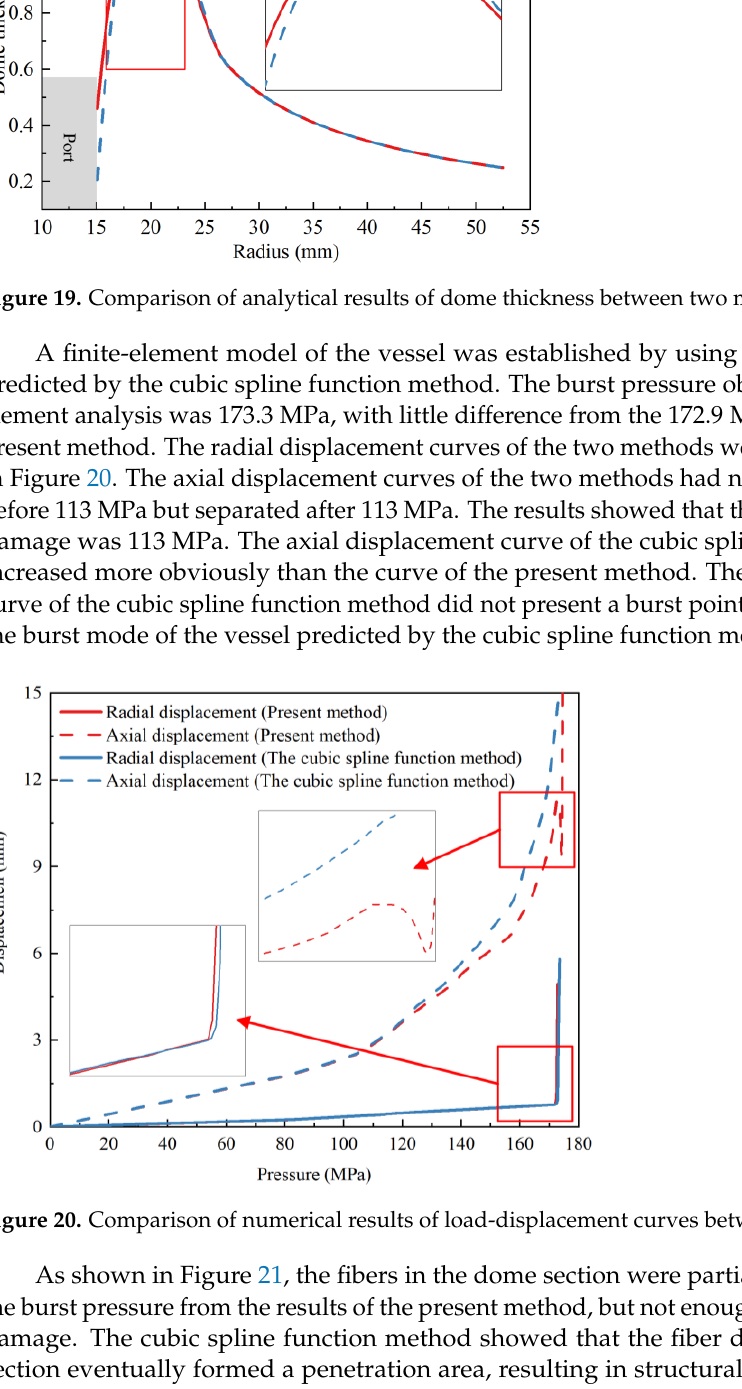
Figure 19. Comparison of analytical results of dome thickness between two methods.